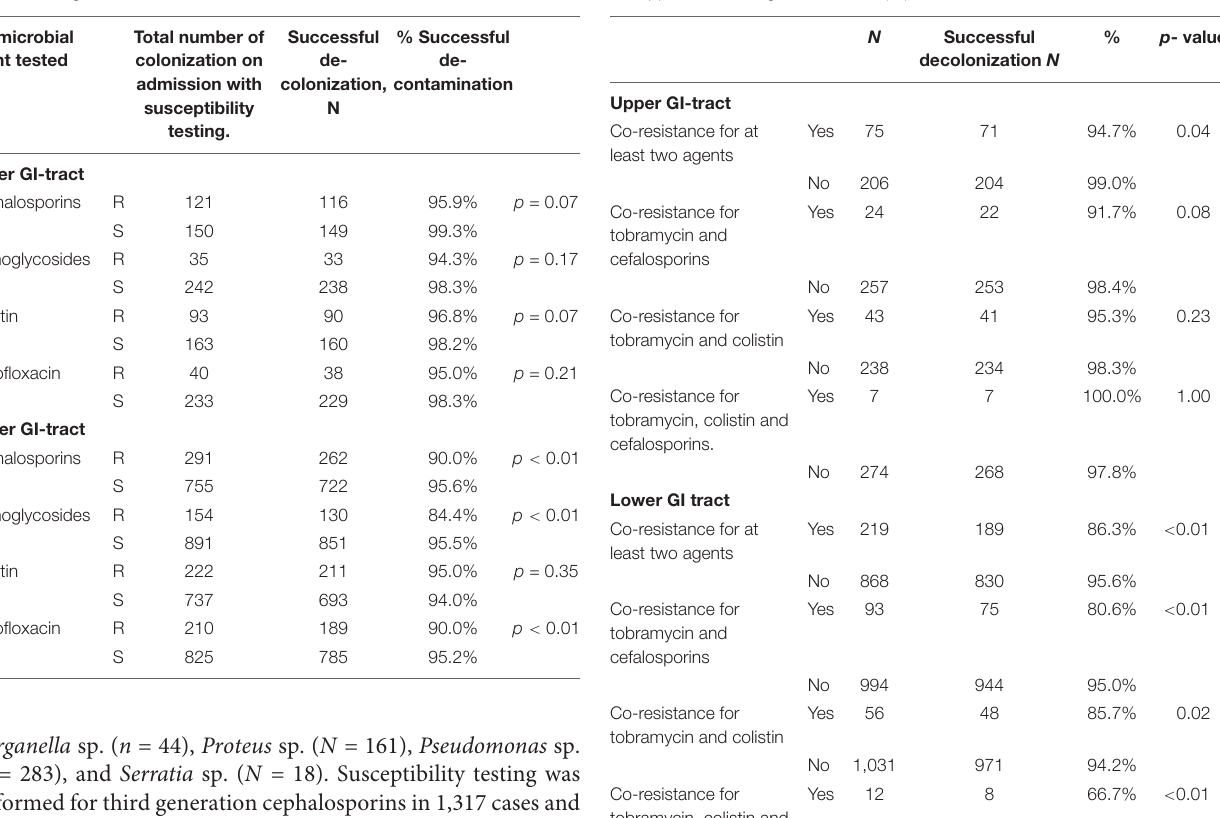
TABLE 4 | Decontamination rates for antimicrobial agents with co-resistance in the upper and lower gastrointestinal (GI)